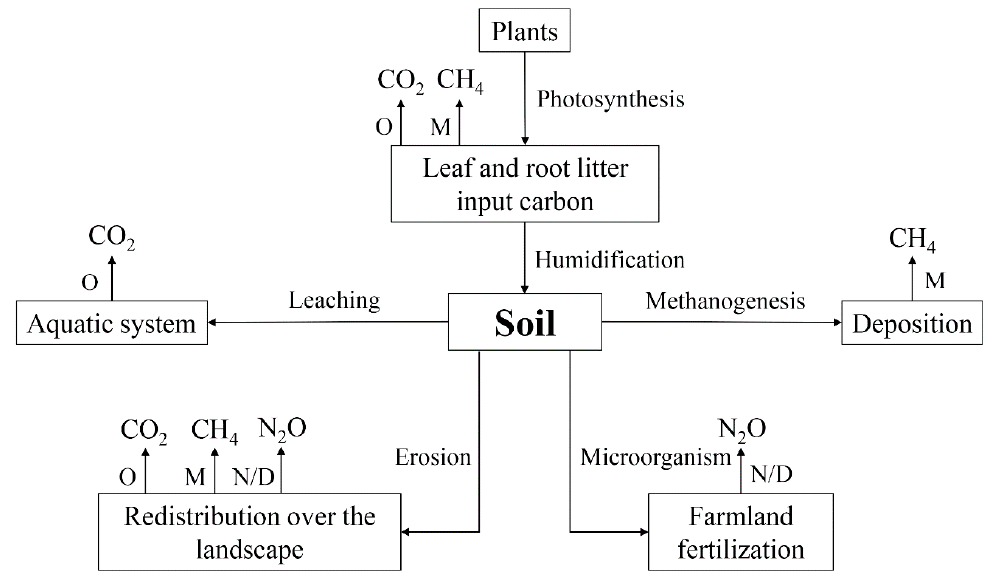
Figure 1. Processes of soil greenhouse gas emissions (modified from Rastogi et al. [3]). O, oxidation; M, methanogenesis; N/D, nitrification and